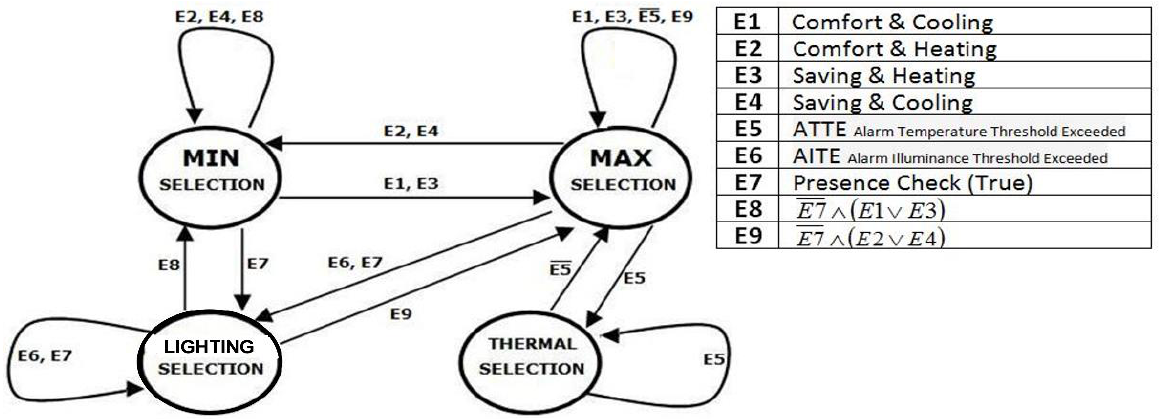
Figure 12. Personal comfort logic (PCL) module configuration ( modified control system).